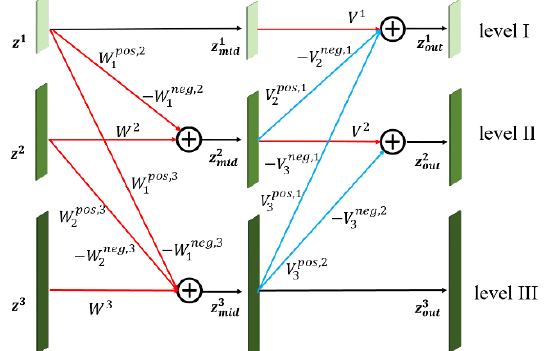
Illustration of the C2F and F2C approaches (see main text for a description of the two strategies). The lines between levels indicate hierarchical relations between classes at different semantic levels. a, b are classes at level I, the classes at the subsequent levels are sub- classes of a and b ,